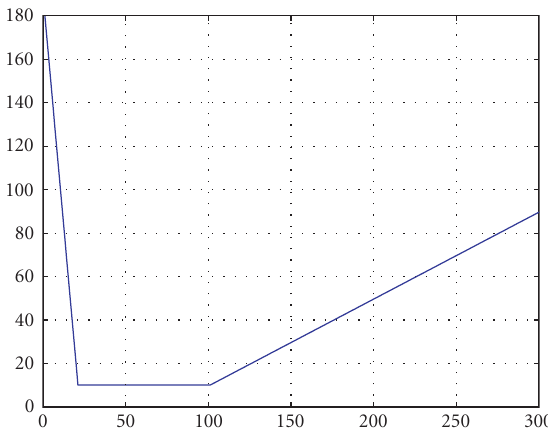
Figure 6: Standard deviation σ in bearing estimation versus range. Here r near = 20 meters, r far = 100 meters, and σ = 10 ◦ in [ r near ,r far ].